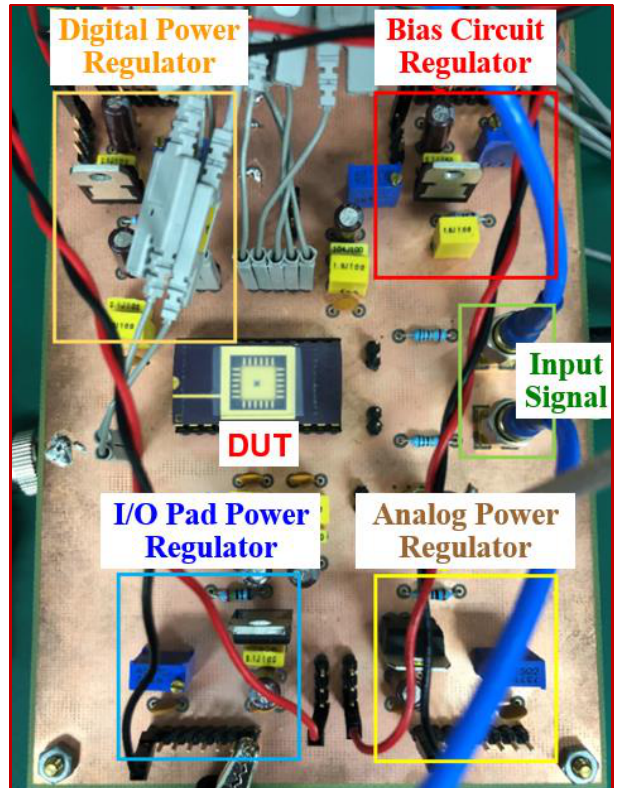
Figure 23. Measured PCB of the proposed PLL-SAR ADC with DUT.